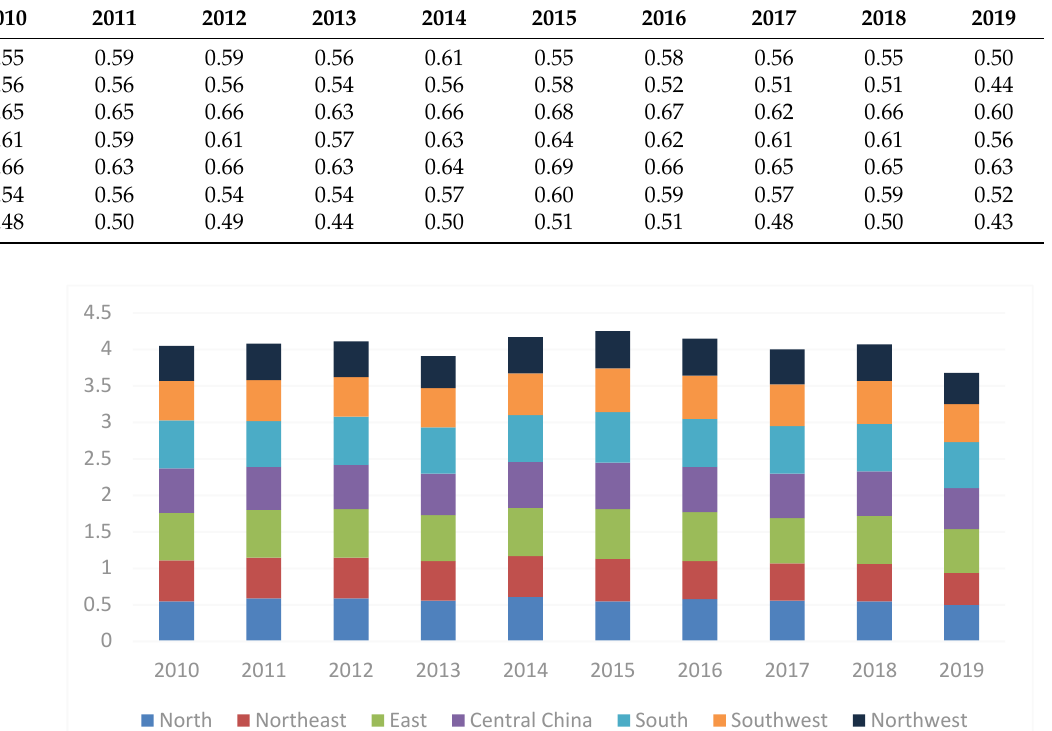
Figure 3. Changing trend in coupling coordination level from 2010 to 2019.